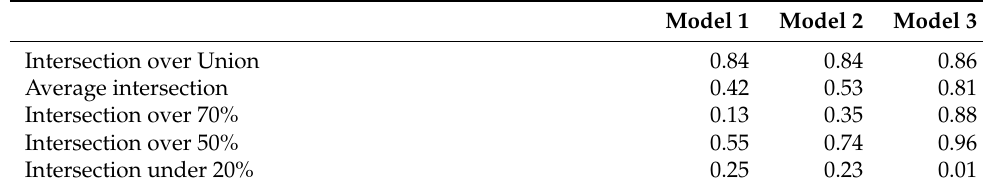
Table 7. Pleura segmentation accuracy over real-life data